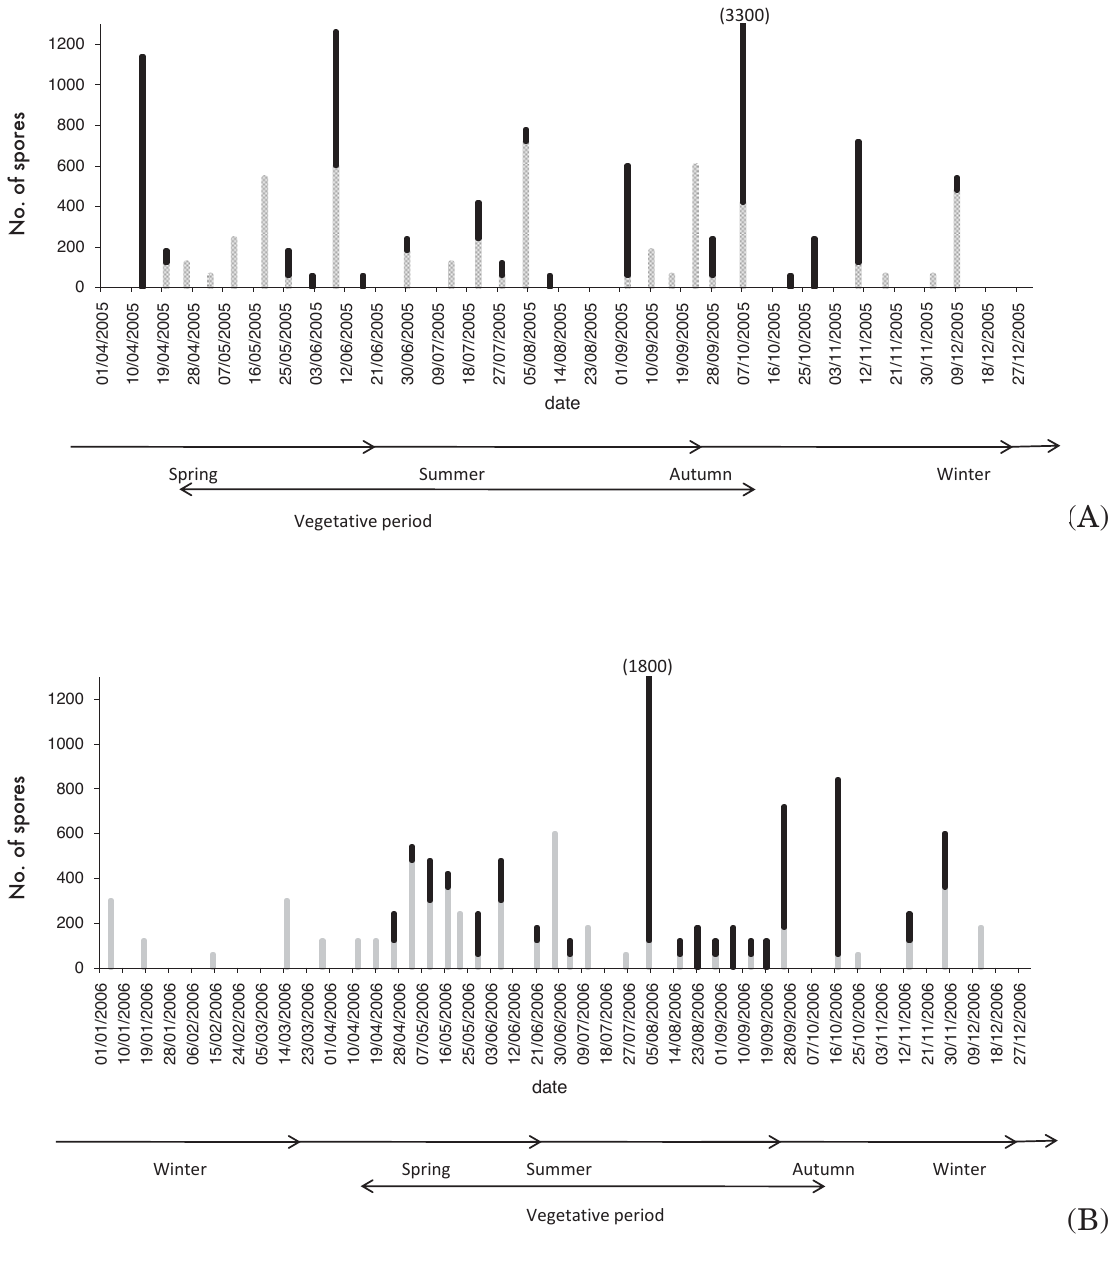
Fig 1 . Cumulative quantity of conidia of Diplodia seriata (grey) and Diplodia mutila (black ) trapped between 6 April 2005 and 21 December 2005 (A), and between 5 January 2006 and 31 December 2006